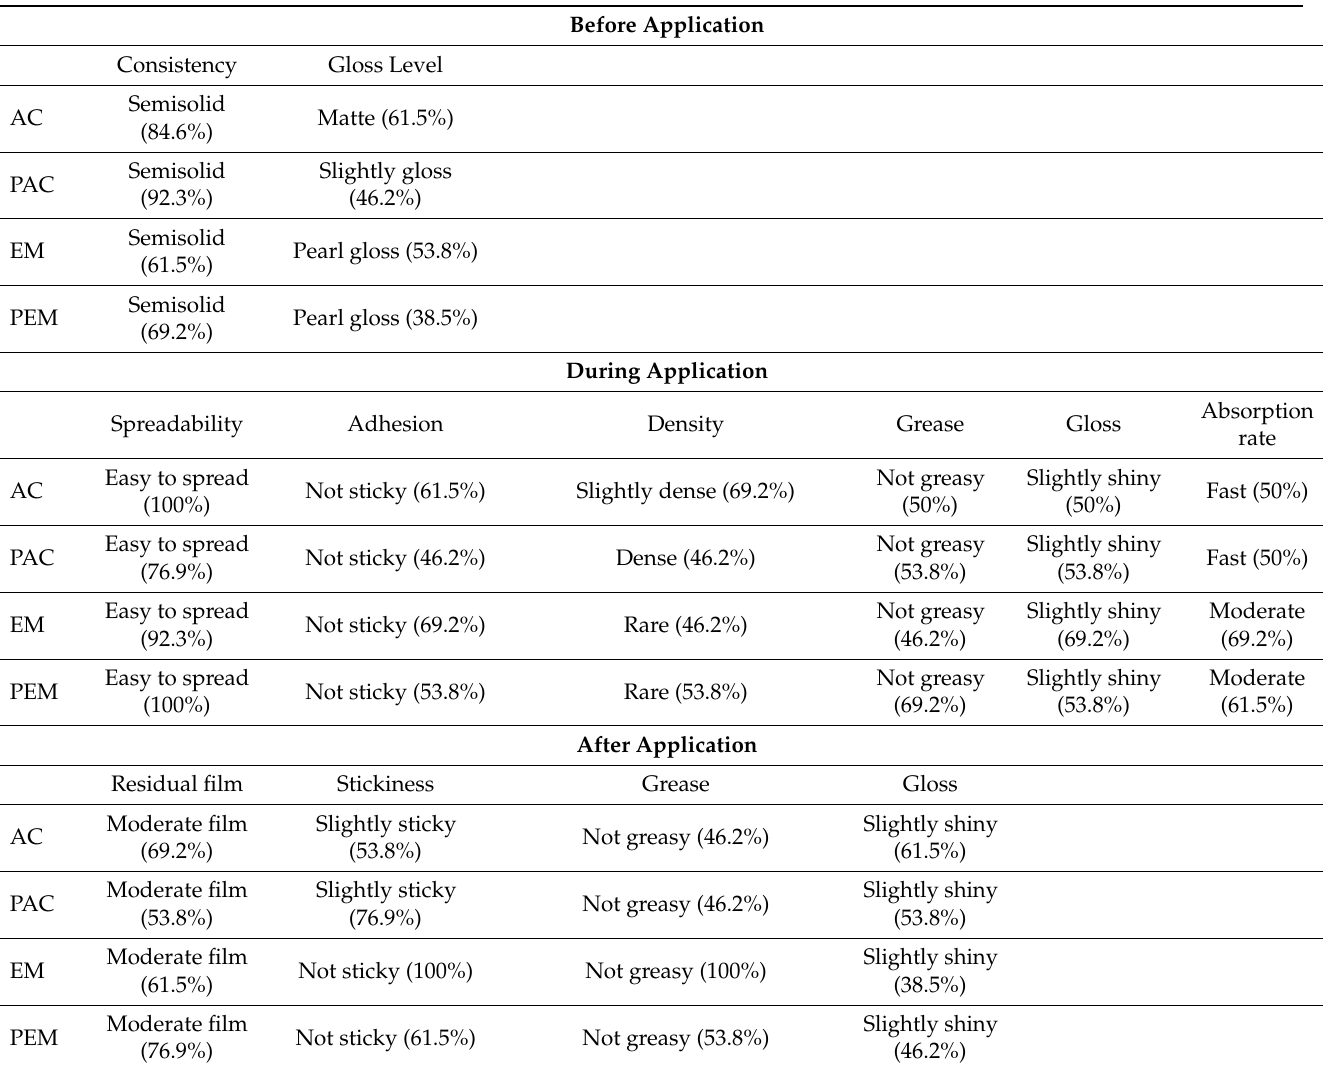
Table 5. The results of sensory analysis of the investigated